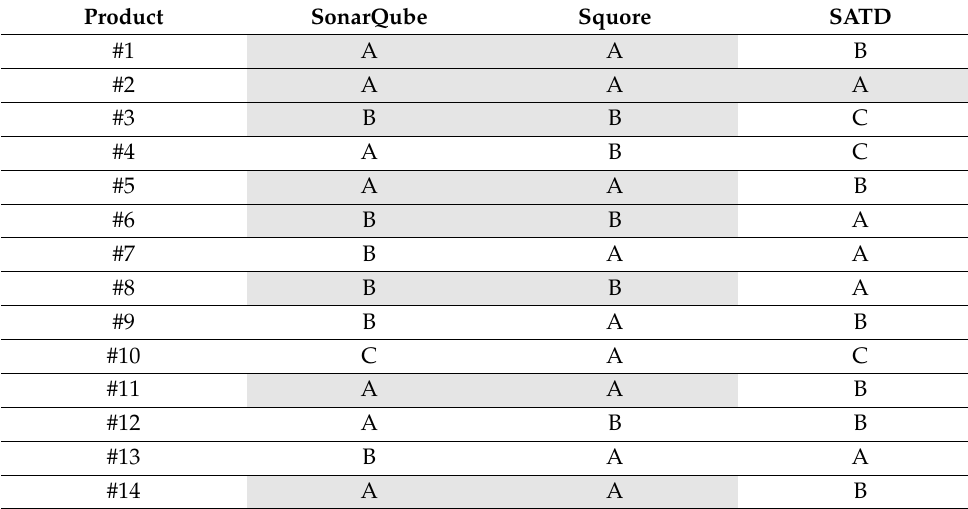
Table 3. Technical debt SQALE rating per